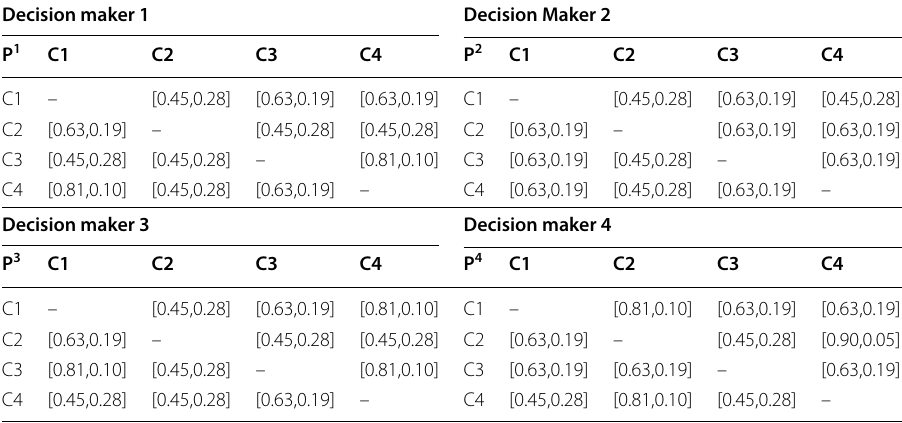
Table 16 Consensus-based Pythagorean fuzzy decision matrix for the equity-based crowdfunding alternative Decision maker 1